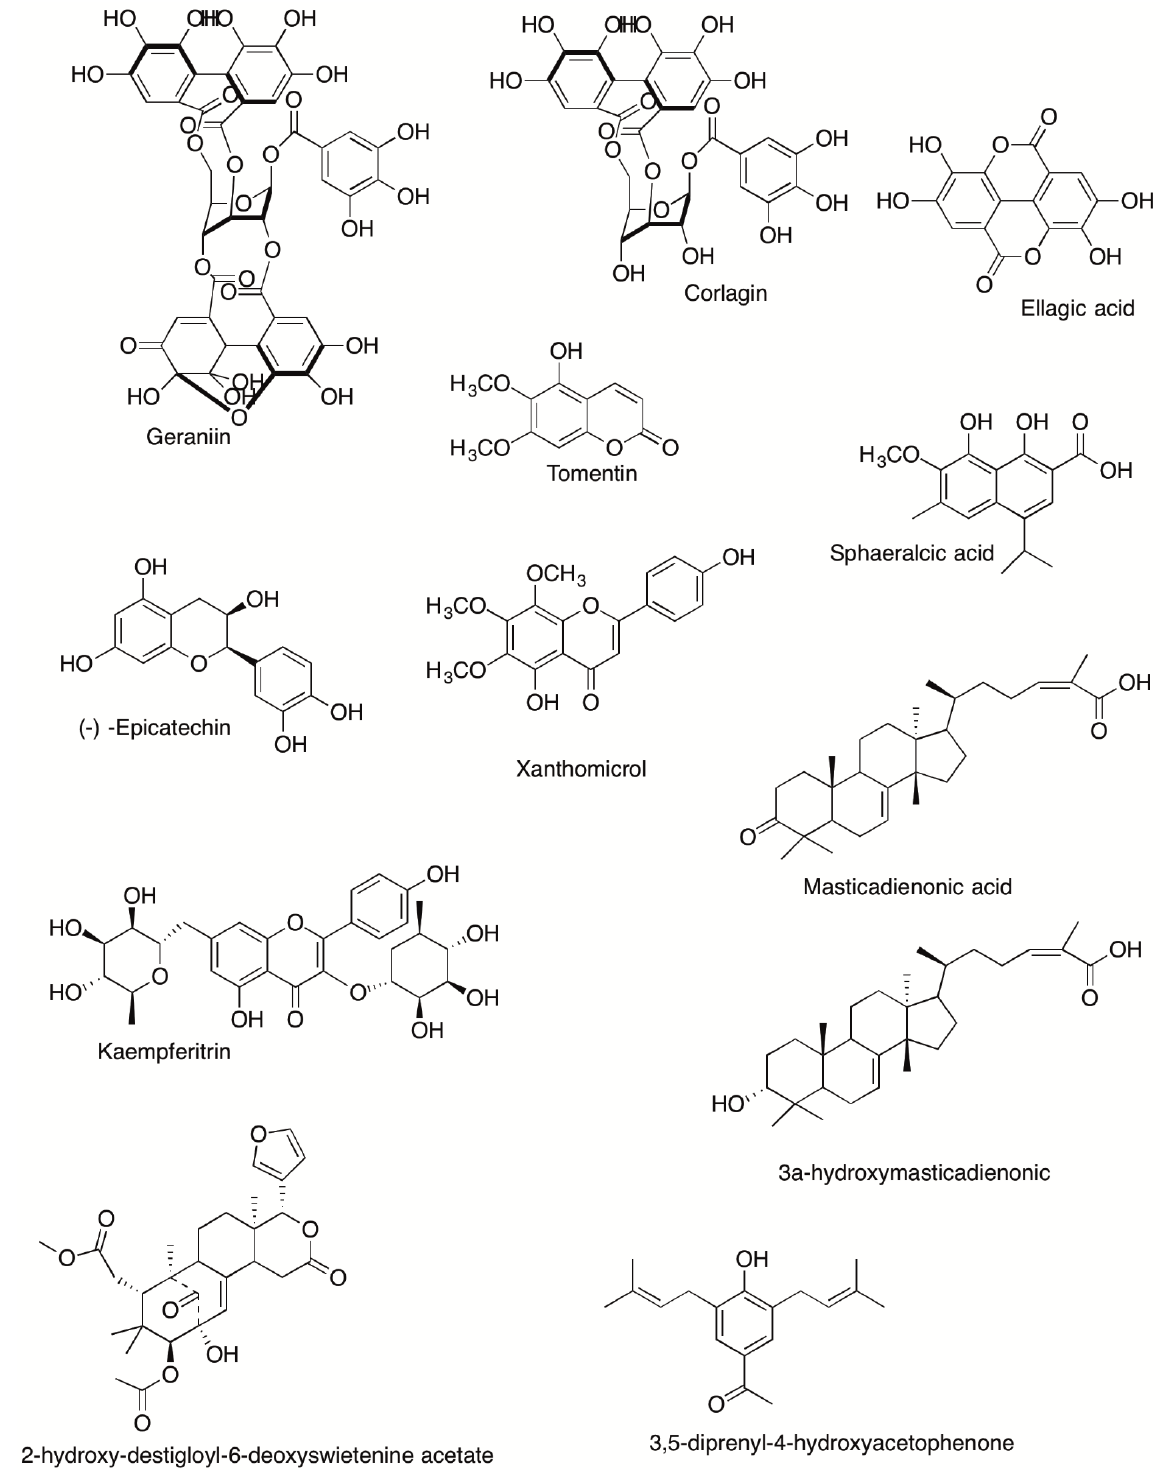
Figure 1. Chemical structures of compounds identified in Mexican plants with anti-inflammatory or antinociceptive effects. 2.2. Heliopsis longipes (A. Gray)